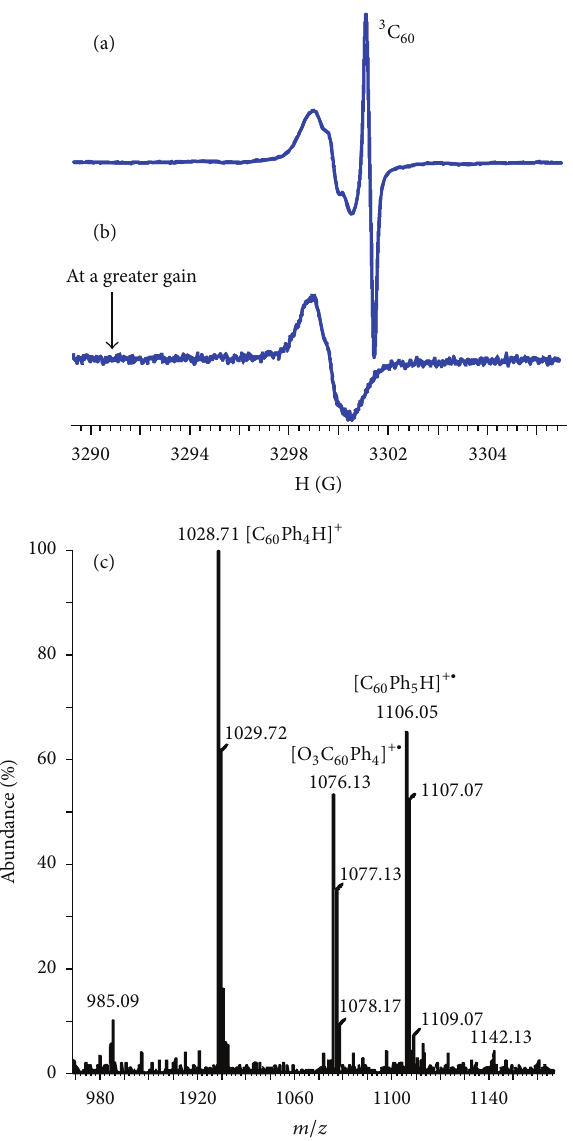
Figure 3: (a) and (b) EPR spectra recorded at 283 K after 30 min UV irradiation of the C 60 , silane 4 reaction mixture with the UV light on and off, respectively. (c) Positive mode APCI mass spectrum in the high mass region of a THF diluted sample of the reaction mixture taken after 30min